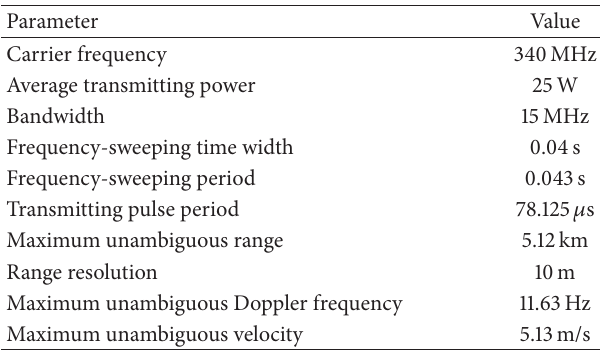
Table 1: UHF radar parameters.